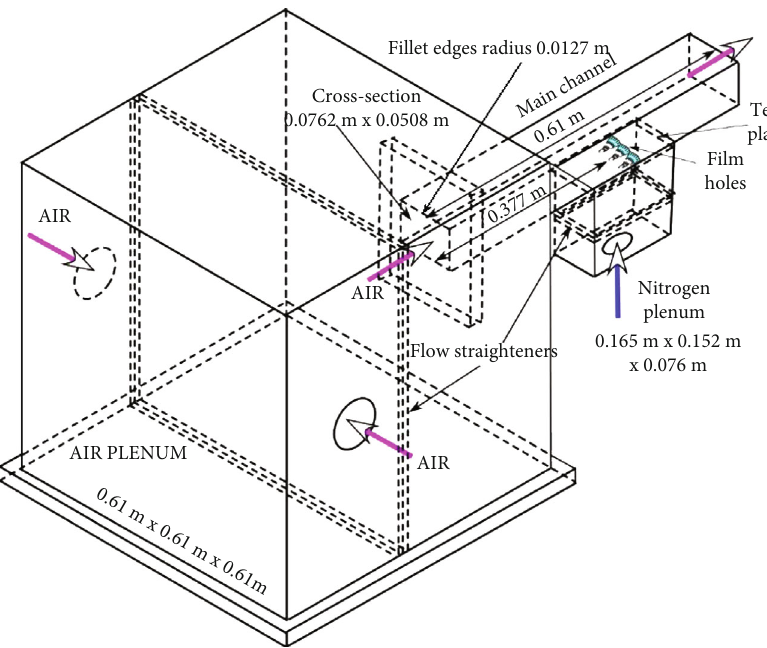
Figure 2: Schematics of the test